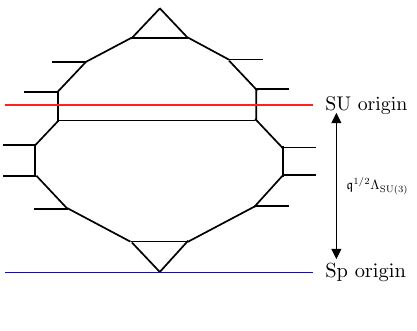
Figure 12 . The difference of the SU origin and the Sp origin. In this figure we omit